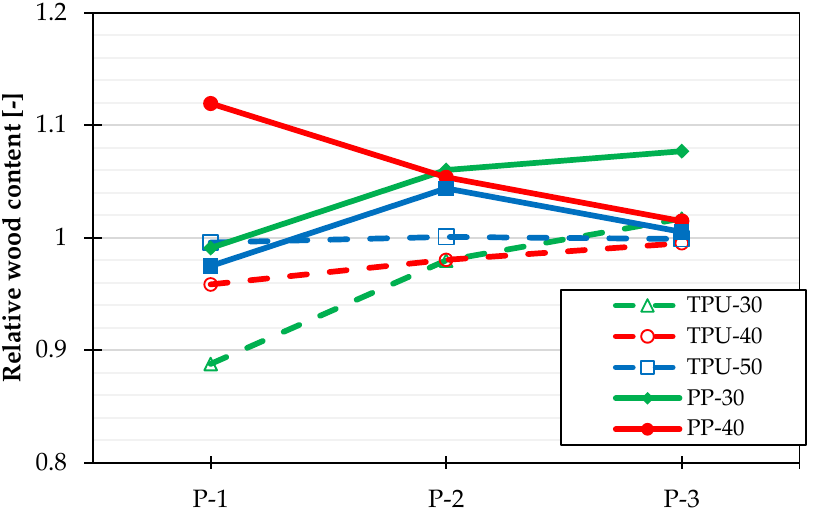
Figure 7. Relative wood content over the removal position of the sheet geometry as a function of the matrix material (TPU, PP) and the wood content (30, 40, 50 wt.%) at a melt temperature of 190 ◦ C and a mold temperature of 60 ◦